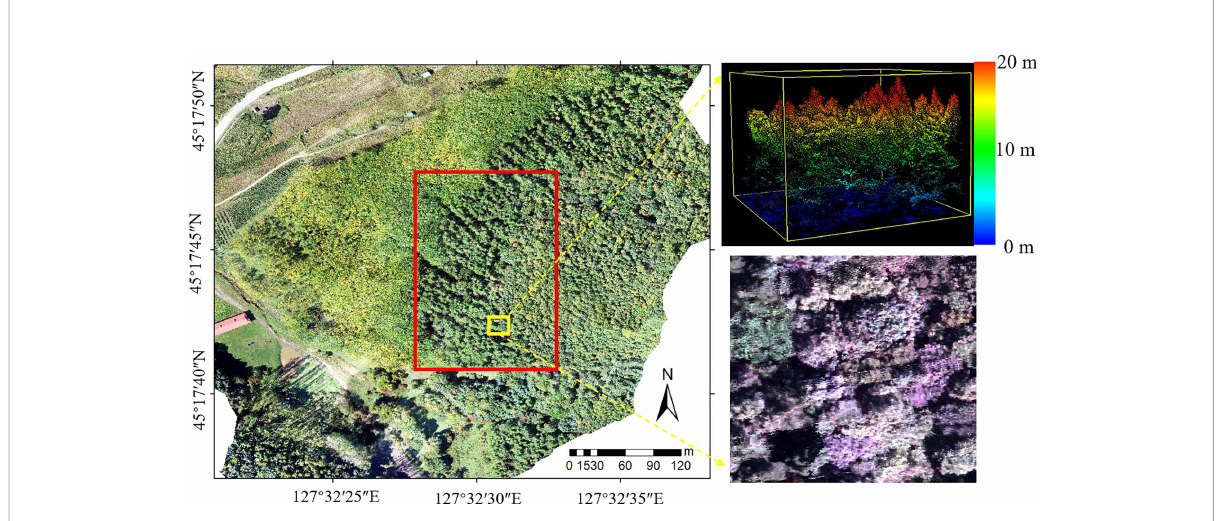
FIGURE 1 Location of the study area (The red frame of the RGB image on the left is the study area; LiDAR and hyperspectral zoomed-in views are on the